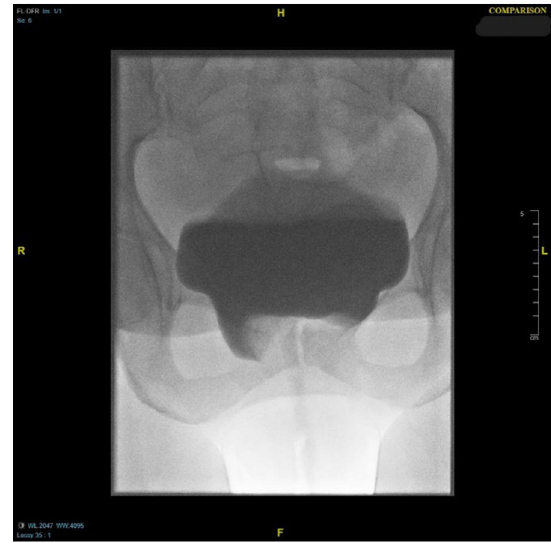
Fig. 1 Sagittal view of leiomyoma and vaginal cyst Fig. 2 Filling phase pre-operative